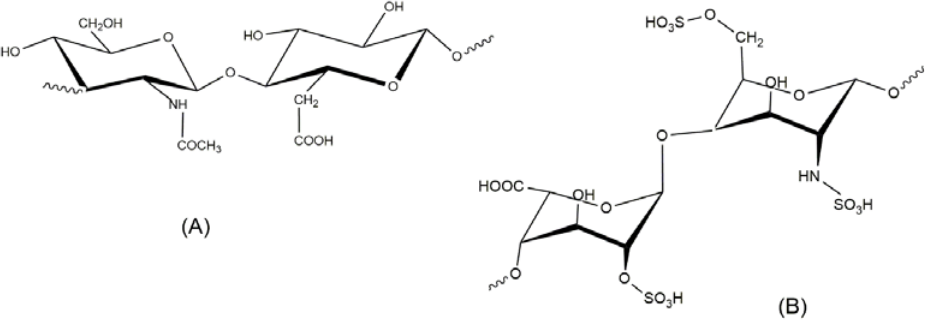
Figure 9. Chemical structures of ( A ) Hyaluronic acid and ( B ) Heparin.